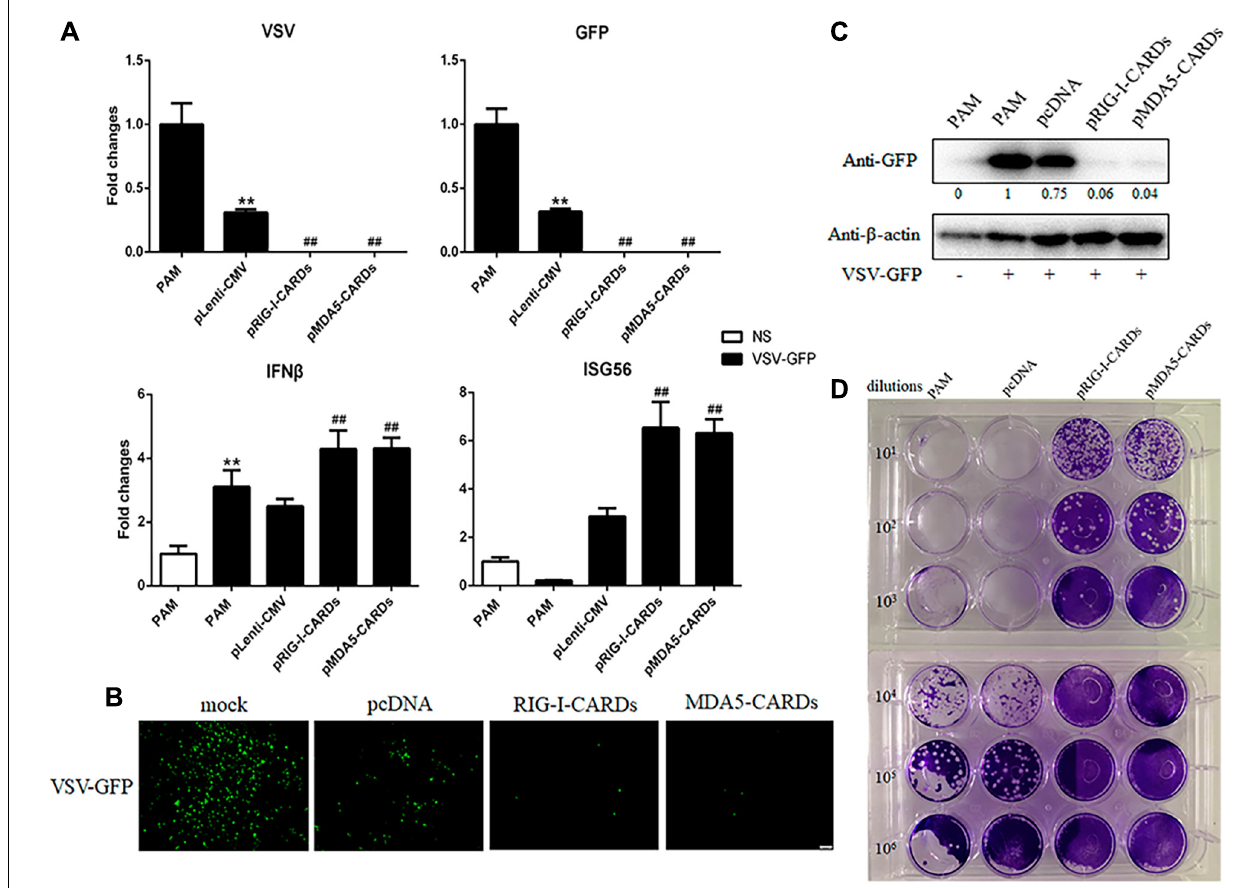
FIGURE 2 | The anti-VSV activity of porcine RIG-I and MDA5 CARDs. (A) PAMs grown on 24-well plates (3 × 10 5 cells/well) were transfected with pLenti-pRIG-I-CARDs-HA and pLenti-pMDA5-CARDs-HA and pLenti-CMV vector (0.5 µ g each) using TransIT-LT1 Transfection Reagent for 24 h. Then the cells were infected with VSV-GFP virus at MOI of 0.01 for 12 h and analyzed by RT-qPCR for virus replication and downstream gene expressions as indicated. (B–D) PAMs grown on 24-well plate were transfected and infected with VSV as above. The GFP signals were visualized under microscope (B) . The cells samples were detected by Western-blotting with anti-GFP mAb, with the densitometry values after actin normalization shown below the GFP blot. (C) . The supernatants from VSV infected PAMs were subjected to infection of Vero cells and the viral plaque were observed at 24 h post infection (D) . ** p < 0.01 vs. blank controls or mock transfection; ## p < 0.01 vs. vector